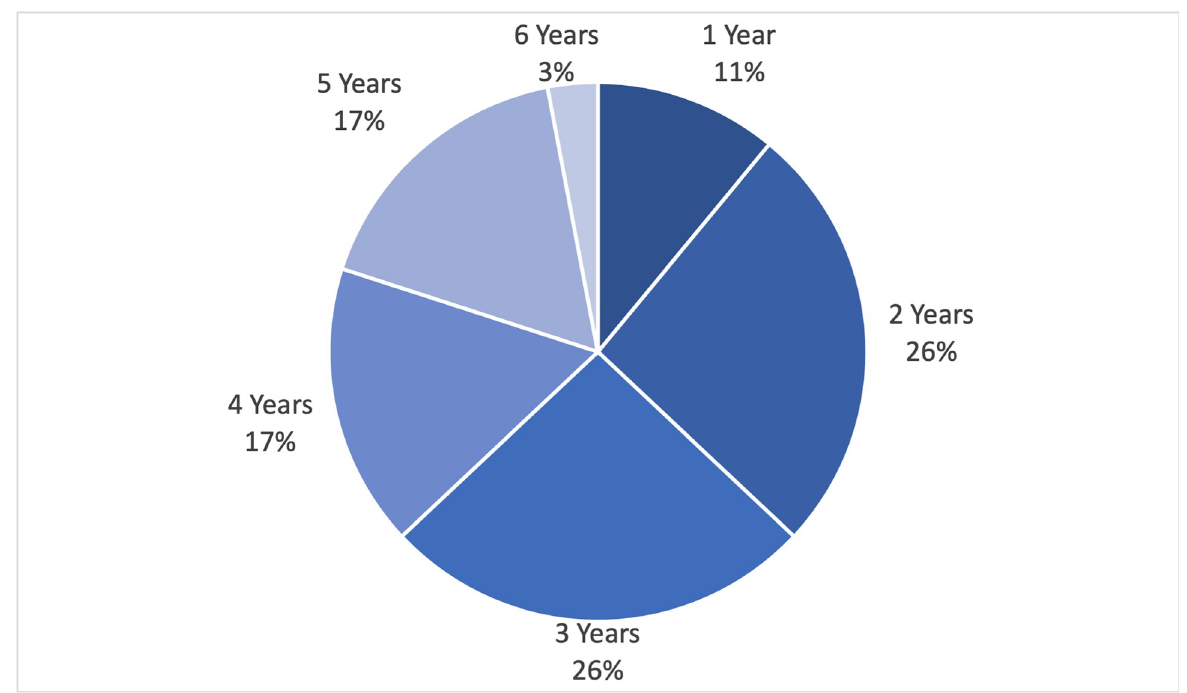
Fig 5. Experts’ working experience seniority.